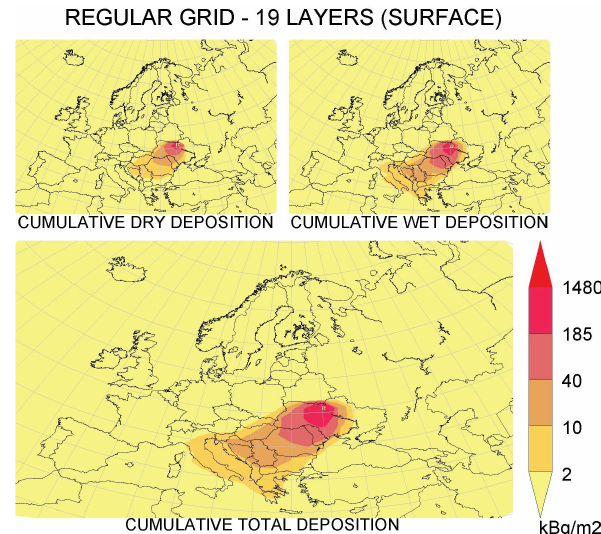
Fig. 10. Cumulative dry, wet and total deposition of 137 Cs (kBqm − 2 ) from the day of the accident (26 April 1986) until the end of 1986. Results of the simulation using the regular grid of the model for 19 vertical layers and accounting for source emissions to occur at the surface